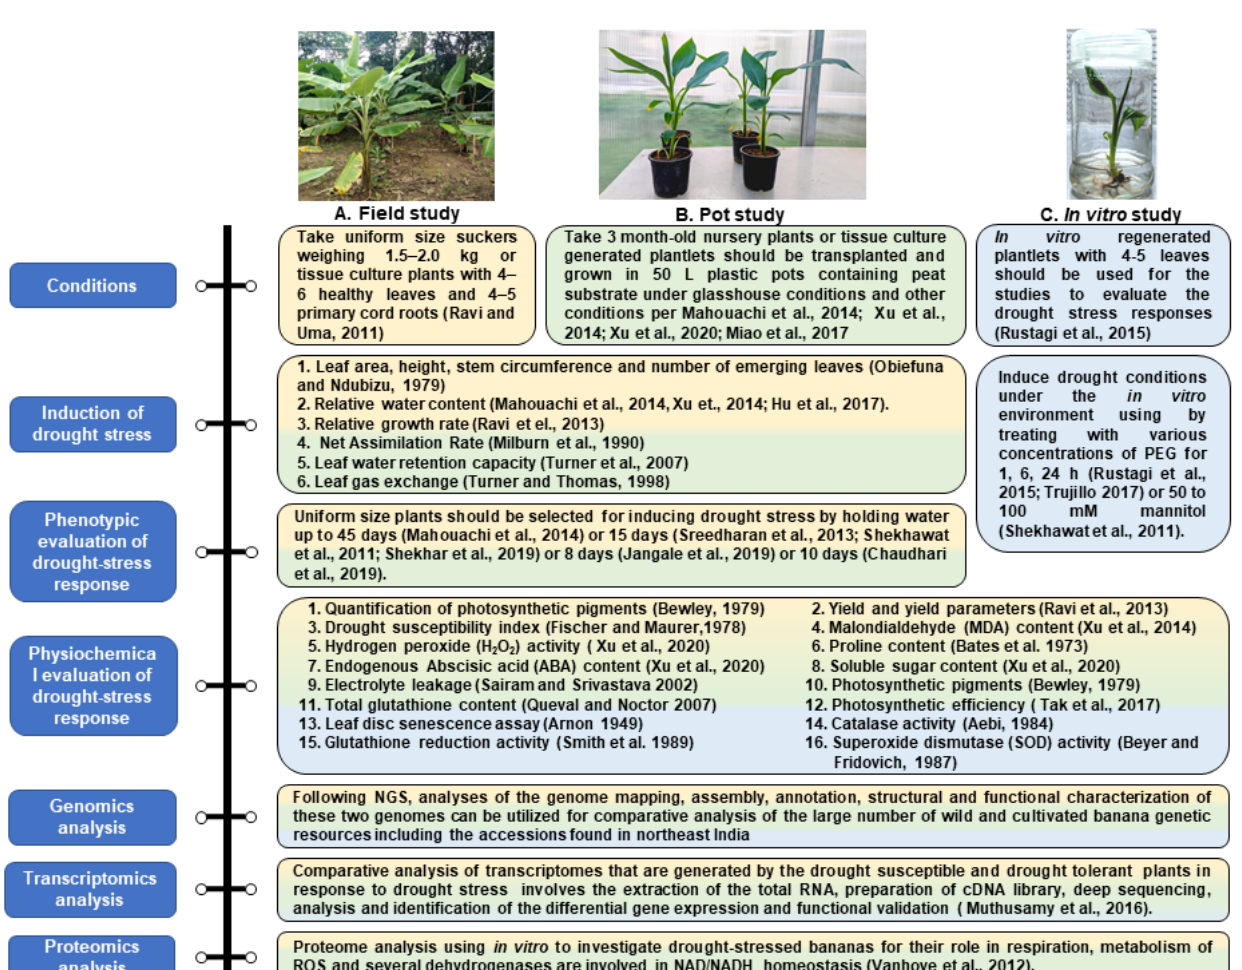
Figure 5. The schematic diagram for evaluating ( A ) Field study, ( B ) Pot study, and ( C ) In vitro study of drought stress response in wild banana genetic resources in northeast India. The figure was adapted from Ravi et al., 2011 [6]; Ravi et al., 2013 [10]; and Vanhove et al., 2012 [69].